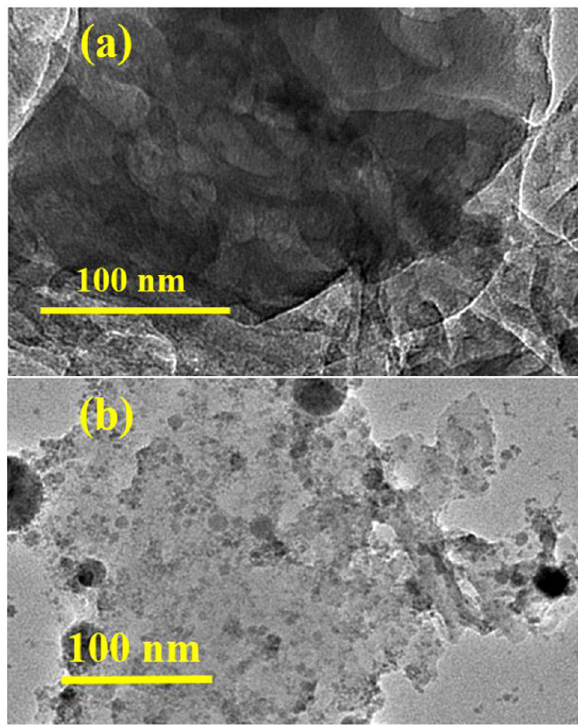
Figure 4: TEM images of g - C 3 N 4 ( a ) and n - NiO@g - C 3 N 4 ( b )